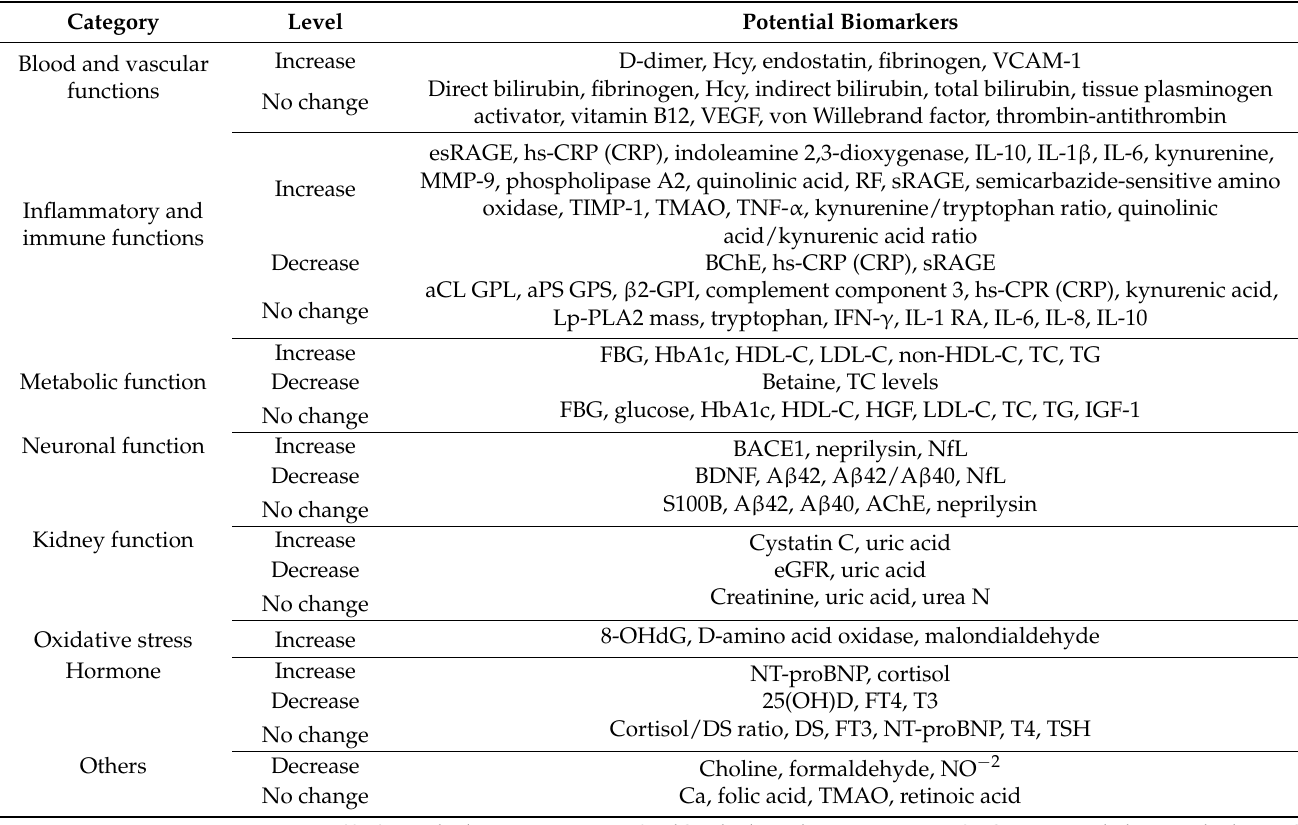
Table 2. Changes in the potential blood biomarkers for